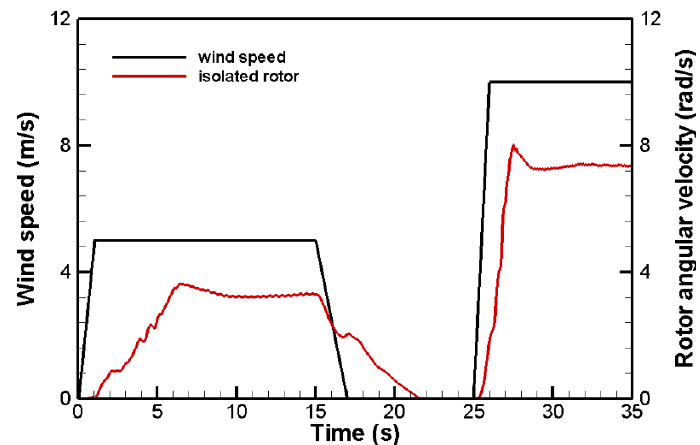
Figure 7. Wind speed (black) and the induced angular velocity of an isolated rotor (red).